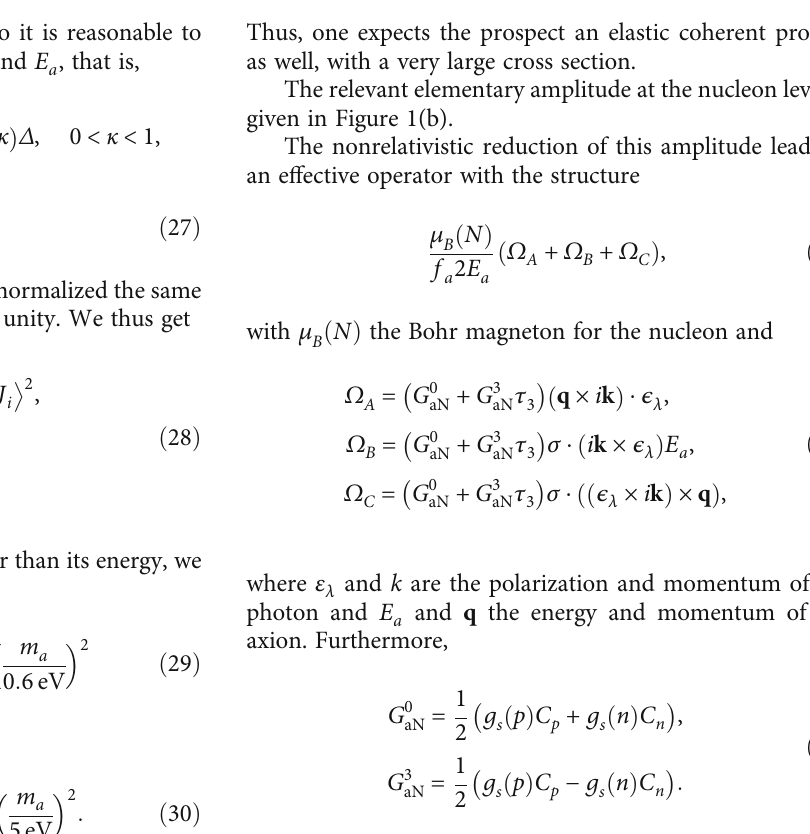
Figure 1: (a) An axion is absorbed by a nucleus leading to an excited nuclear state. (b) A Feynman diagram relevant for axion photoproduction. In both cases, in the axion vertex, we encounter the coupling given by Equation (17), while in the EM vertex in (b), we have the usual interaction involving the nuclear magnetic moment. p , q , and k are the initial nucleon, axion, and photon 4-momenta, respectively. In both cases of (a) and (b), the output signal energies are the same,